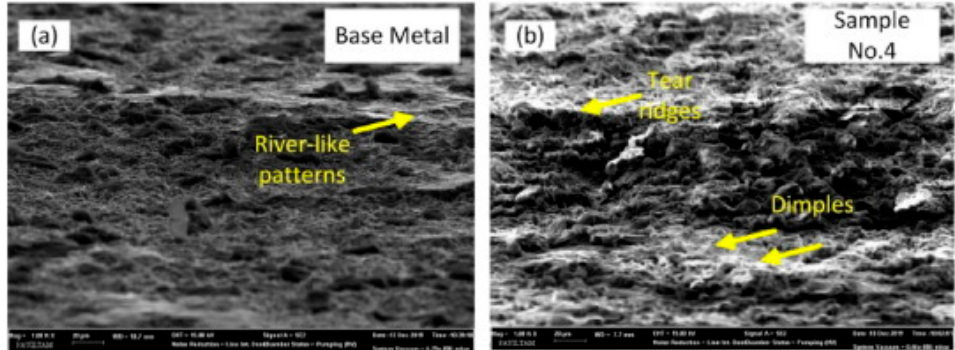
Figure 16. The fracture morphology ( a ) in XPF800 and ( b ) FZ. Reprinted with permission from